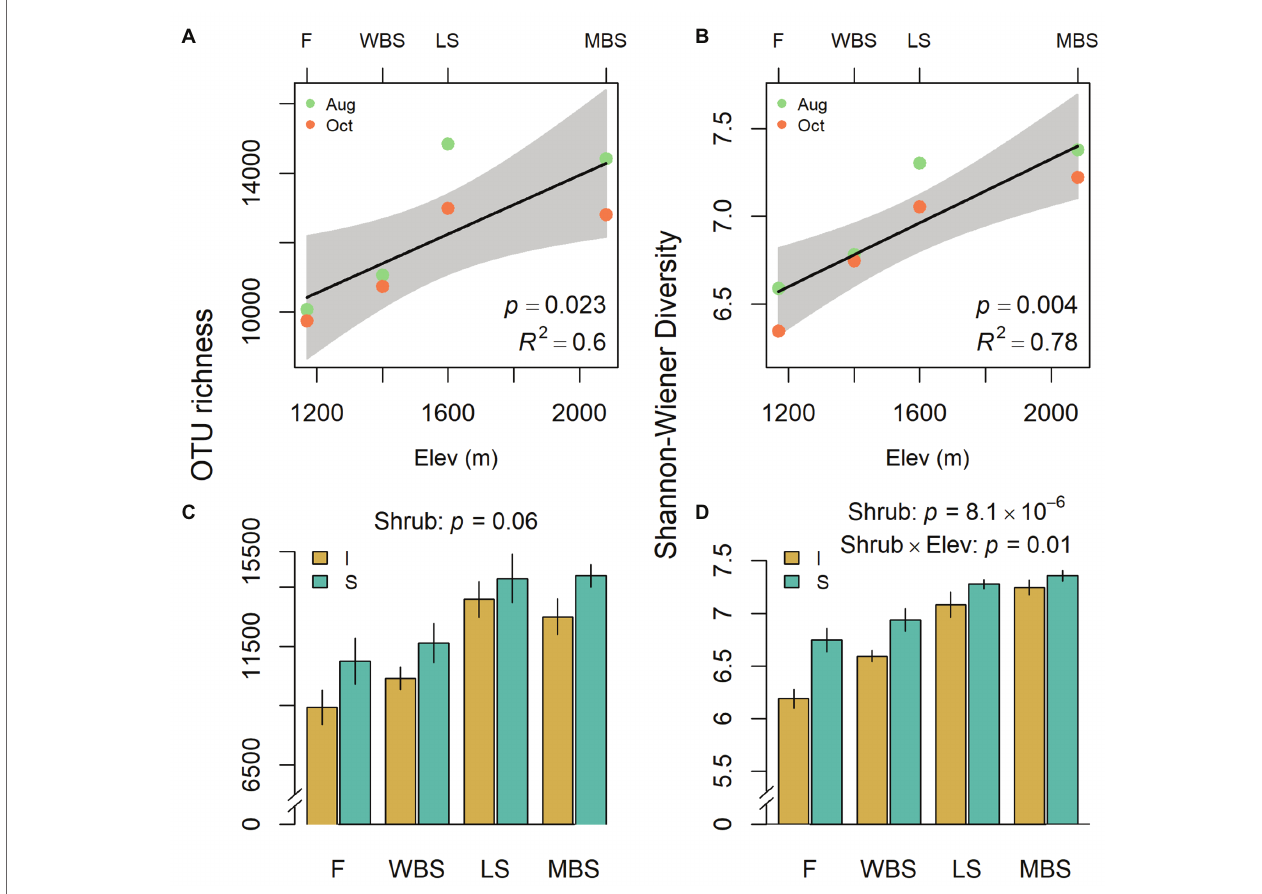
FIGURE 4 | Variation in operational taxonomic unit (OTU) richness (A,C) and Shannon diversity (B,D) with respect to elevation (A,B) and shrub/intershrub levels (C,D) . Shading around regression fits in (A,B) are 95% confidence intervals for true fitted values. Errors in (C,D) are